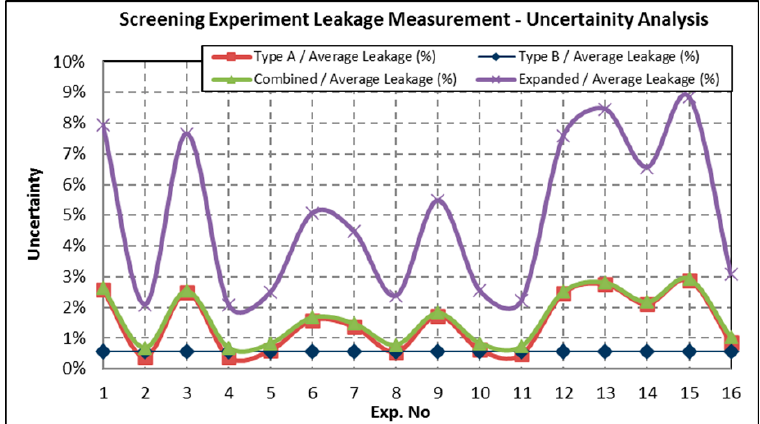
Figure A1. Uncertainty analyses for screening experiments.